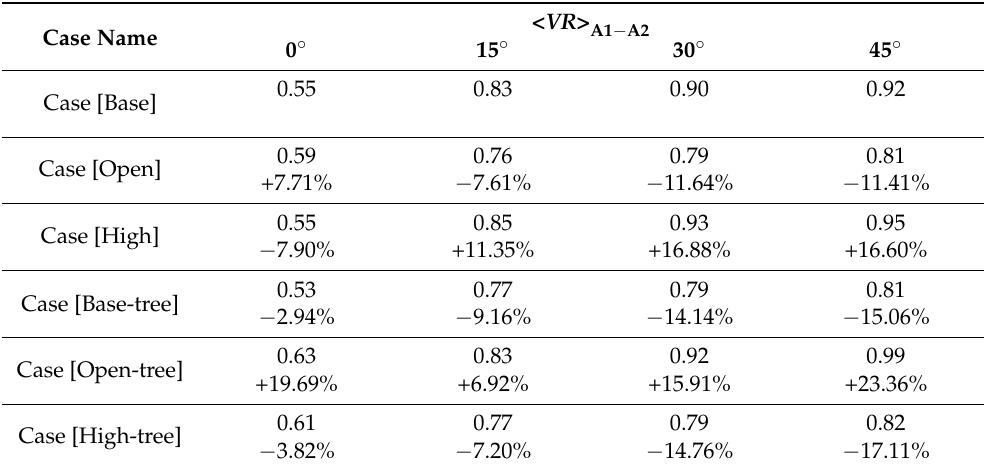
Table A8. Spatial mean velocity ratio ( VR ) at z = 2 m in the Region A1 − A2 (< VR > A1 − A2 ) of each scenario and the change rate.